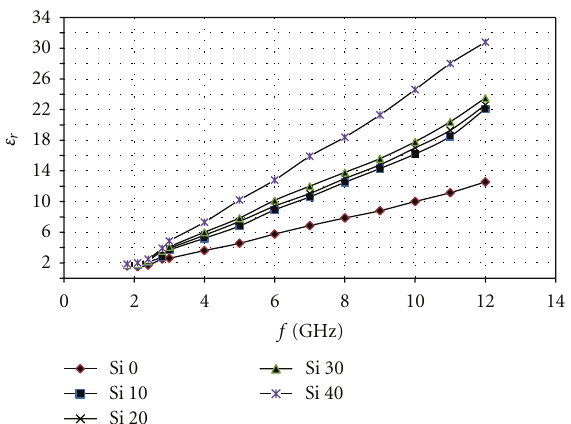
Figure 3: Frequency ( f , GHz) dependence of relative dielectric permittivity ( ε r ) at various filler content in the composites.